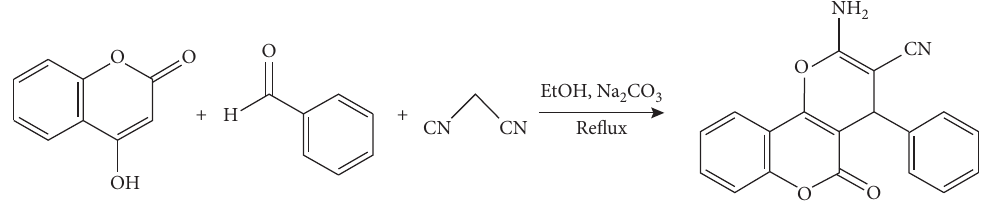
Figure 1: The synthesis pathway of the Chrom-D compound.